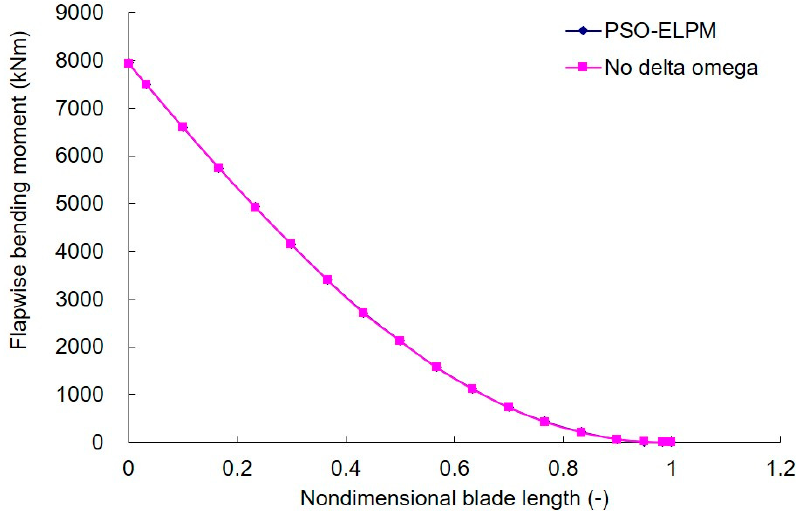
Figure 15. Comparison of extreme edgewise bending moment along the blade (1.5 MW).